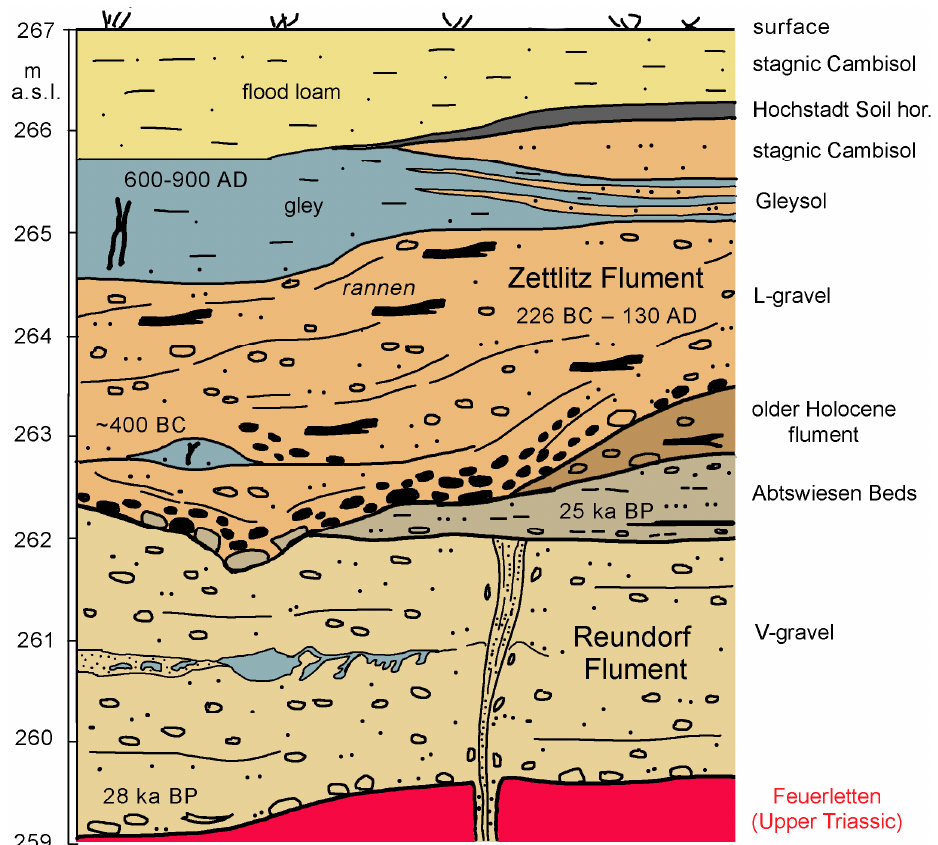
Figure 18. Stacked fluments in the valley underground below a Holocene terrace. Sketch of an area of several gravel pits in the Zettlitz Terrace in Lichtenfels-Trieb / Bavaria. The Reundorf Flument is preserved by its socle containing the interstadial Abtswiesen Beds. These Pleniglacial deposits are unconformably overlain by the roughly 2000 years old Zettlitz Flument that is completed by the Early Medieval Hochstadt Soil horizon [54] (p. 52), since then overlain by younger flood deposits.